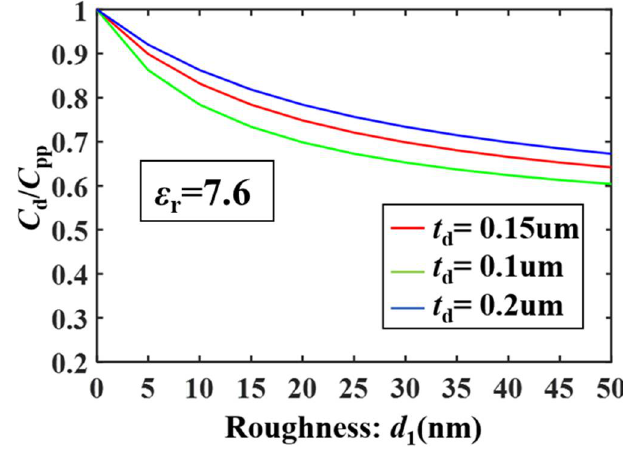
Figure 2. Simulation curves of roughness and C d .